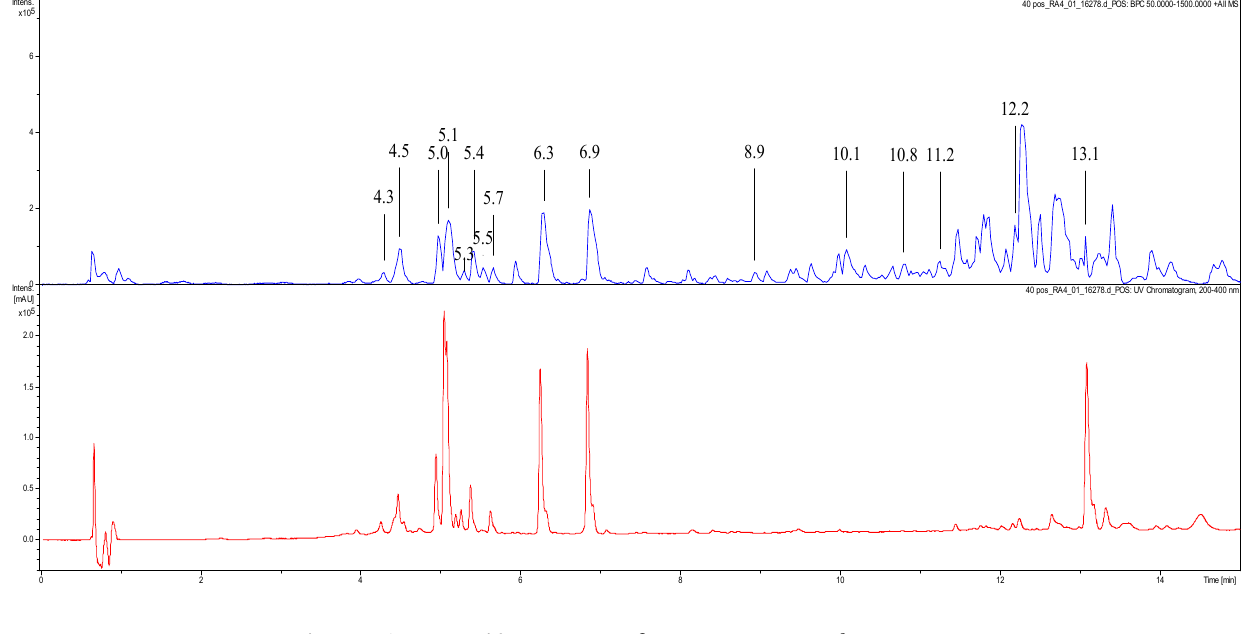
Figure A5. ID_40: Extract of Hypericum perforatum L. Table A7. Dereplication results for